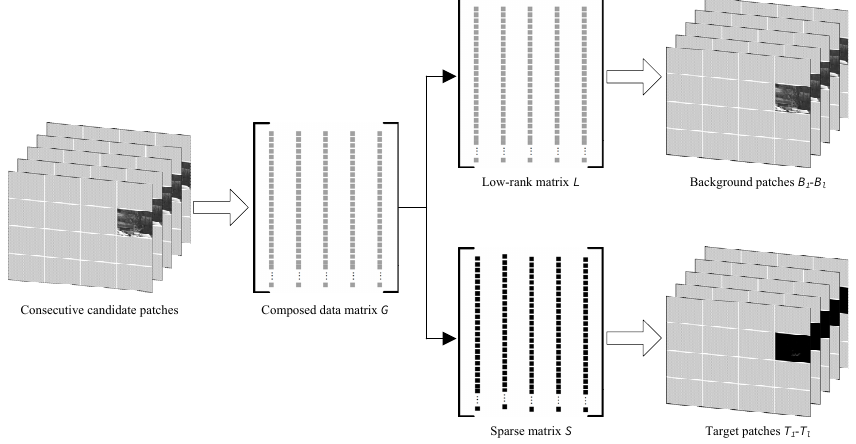
Figure 2. Local foreground-background images separation via